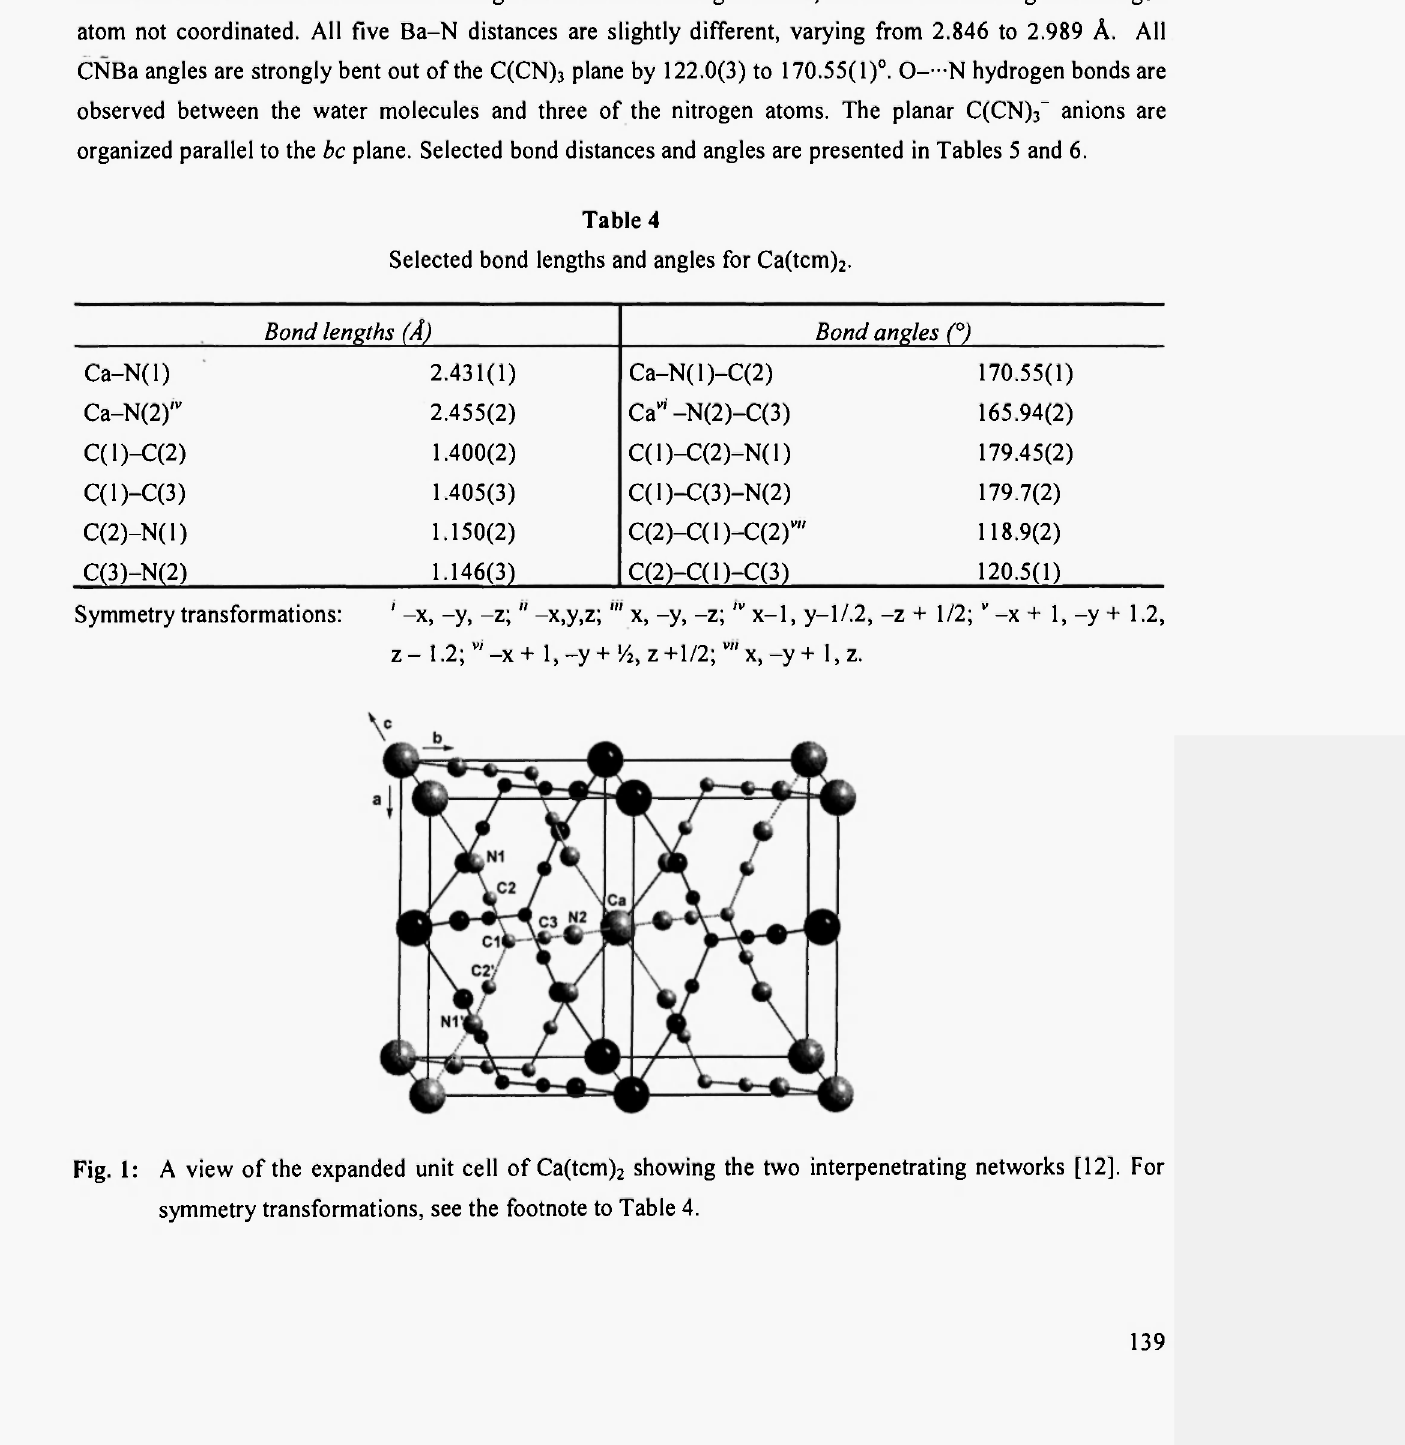
Fig. 1: A view of the expanded unit cell of Ca(tcm) 2 showing the two interpenetrating networks [12]. For symmetry transformations, see the footnote to Table